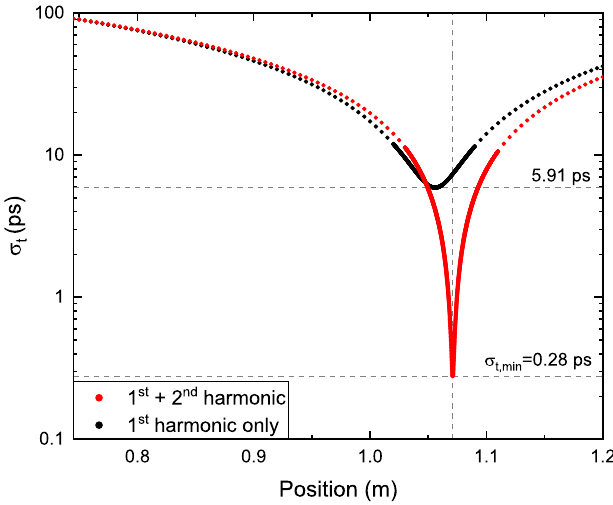
FIG. 9. RMS temporal bunch length during compression. Initial pulse length is 95.57 ps.